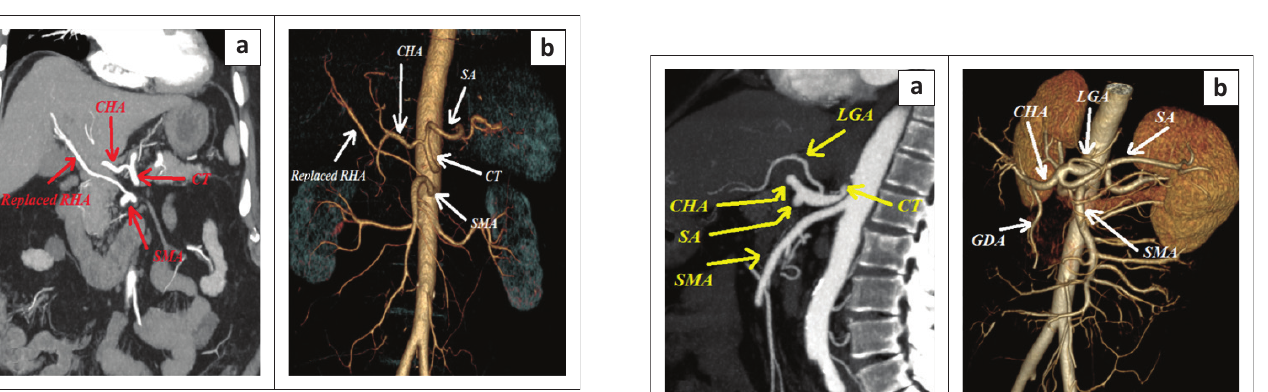
FIGURE 3: Sagittal multiplanar reconstruction (a) and three-dimensional (b) images show Ulflacker's Type 1 non-classic